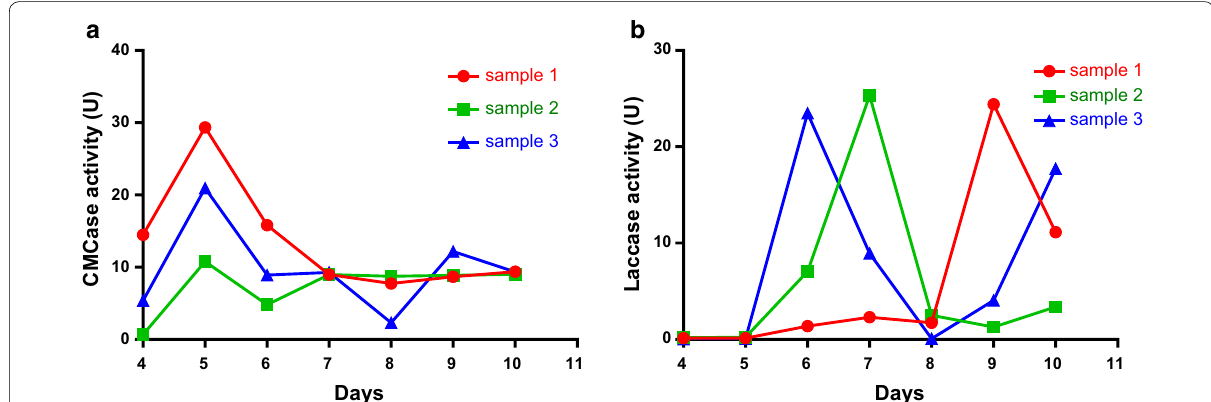
Fig. 1 a CMCase activity of C. comatus during liquid-state fermentation. b Laccase activity of C. comatus during liquid-state fermentation